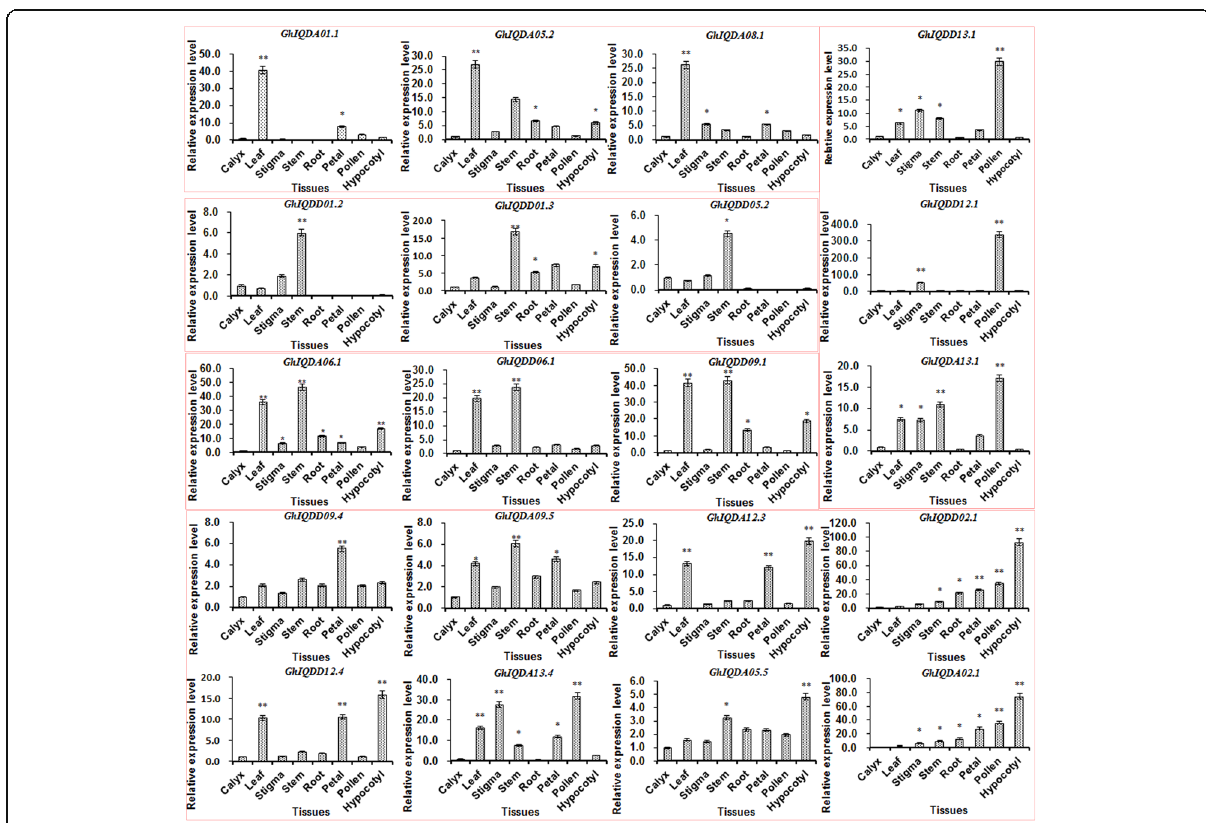
Fig. 5 Tissue-specific expression analysis of 20 selected GhIQD genes by qRT-PCR. The relative expression levels of 20 GhIQD genes were examined by qRT-PCR assays and normalized to the expression level of the house-keeping gene GhHis3 . The calyx, leaf, stigma, stem, root, petal, pollen, and hypocotyl tissues are indicated on the X-axis. Relative gene expression levels compared with the calyx are indicated on the Y-axis, * represents a significant difference at the p < 0.05 level, ** represents an extremely significant difference at the p < 0.01